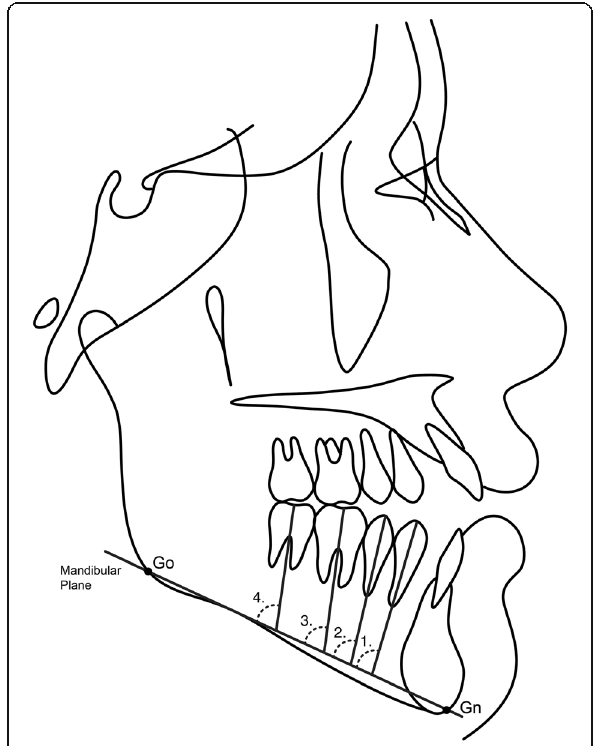
Fig. 4 Posterior teeth angulations measurements in the